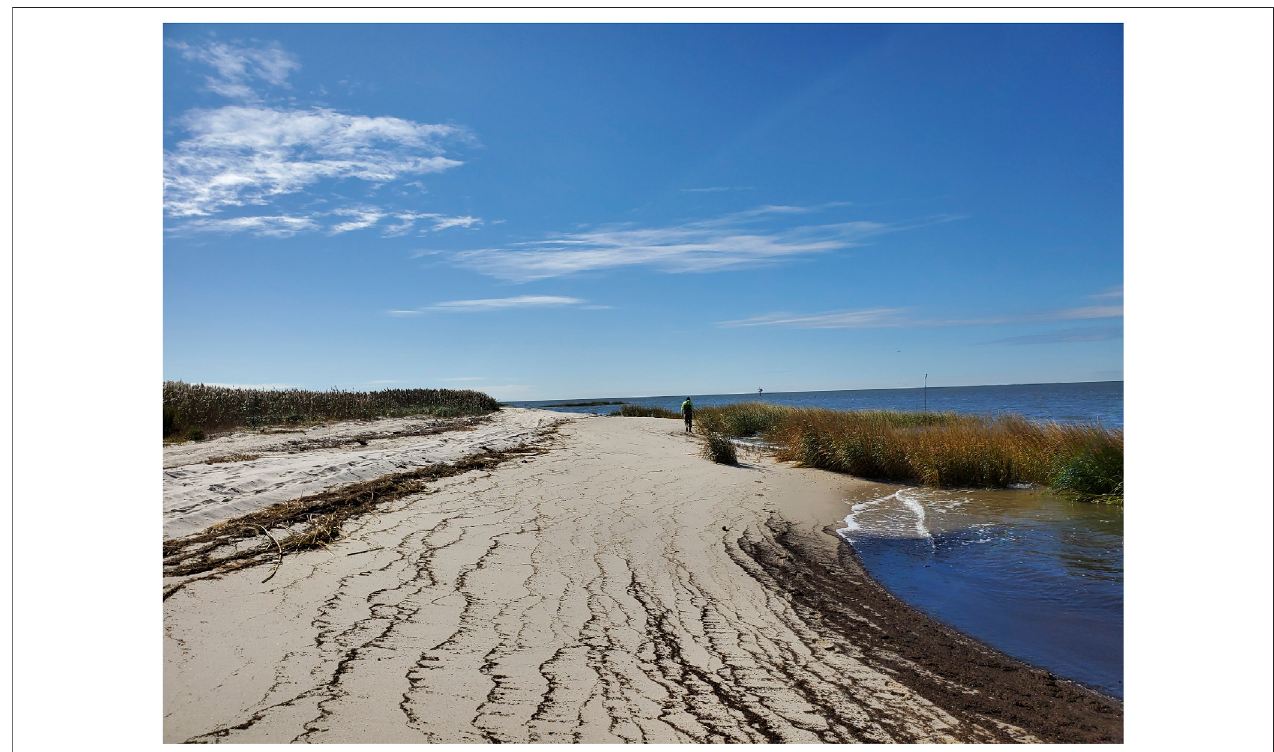
FIGURE 1 | Photograph of Gandys Beach preserve near Site A, October